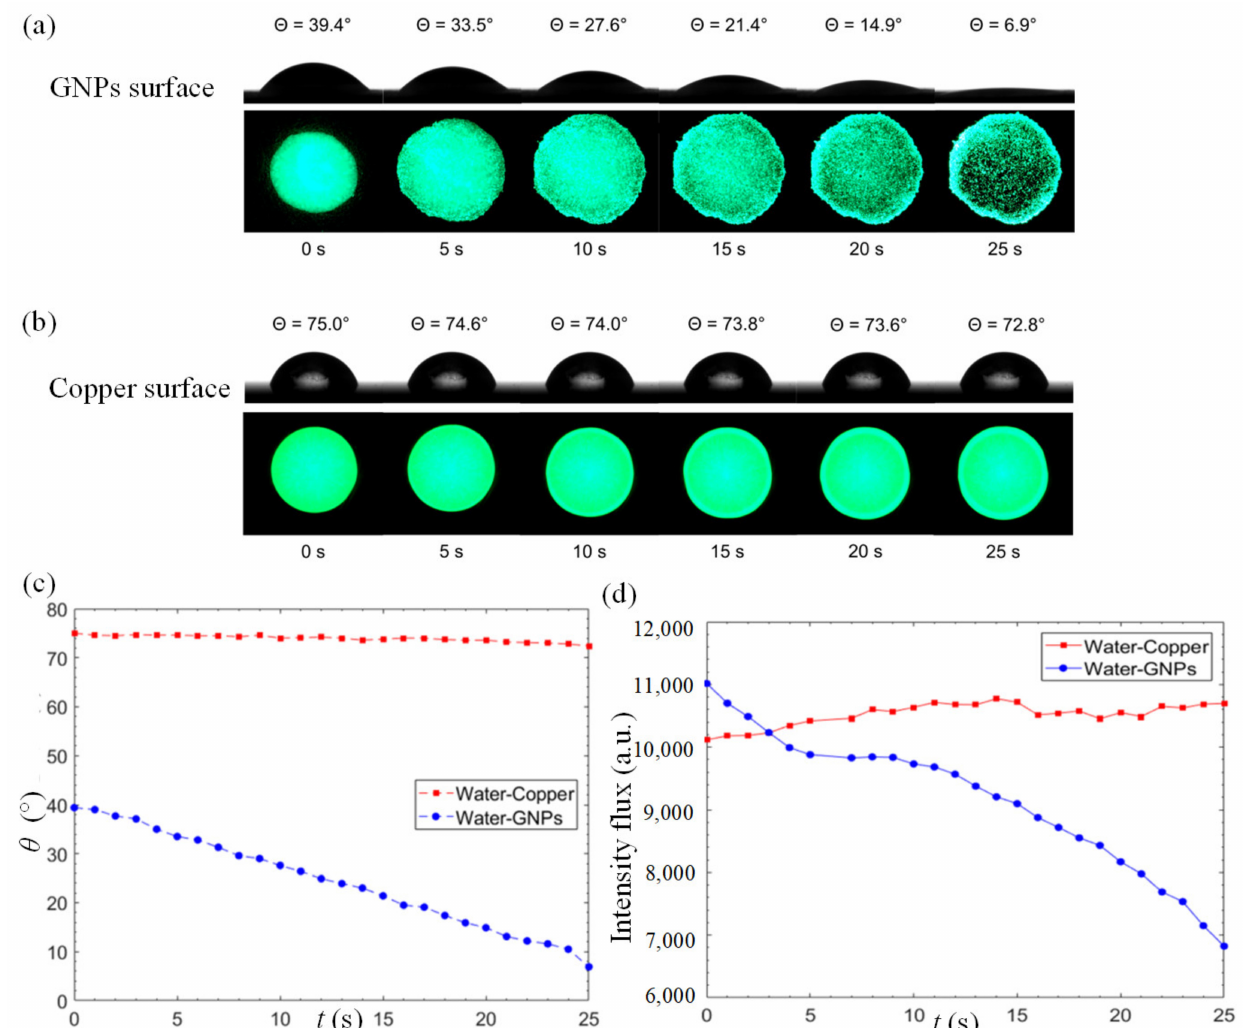
Figure 3. Time-lapse goniometry images of water droplet contact angle and digital images of fluorescence-dyed water droplet on the ( a ) GNPs, and ( b ) copper surfaces. ( c ) Static contact angle of a 3 µ L fluorescent water droplet on the GNPs-coated and the copper surfaces as a function of time. ( d ) Intensity flux of a 3 µ L fluorescent water droplet on the GNP-coated and copper surfaces as a function of